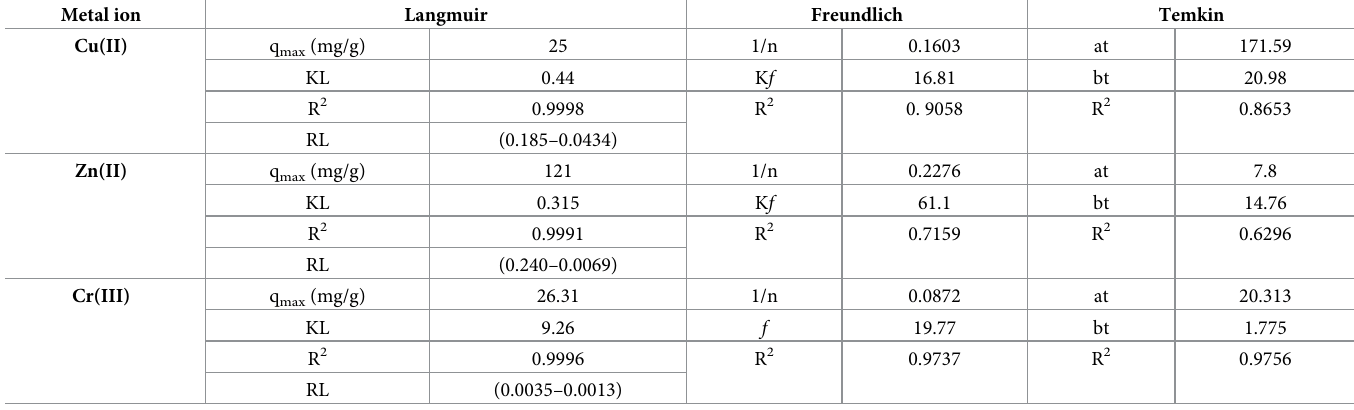
Table 5. Study of isotherm models correlation coefficients and constant for adsorption of Cu(II), Zn(II), and Cr(III) ion on imine. Metal ion Langmuir Freundlich